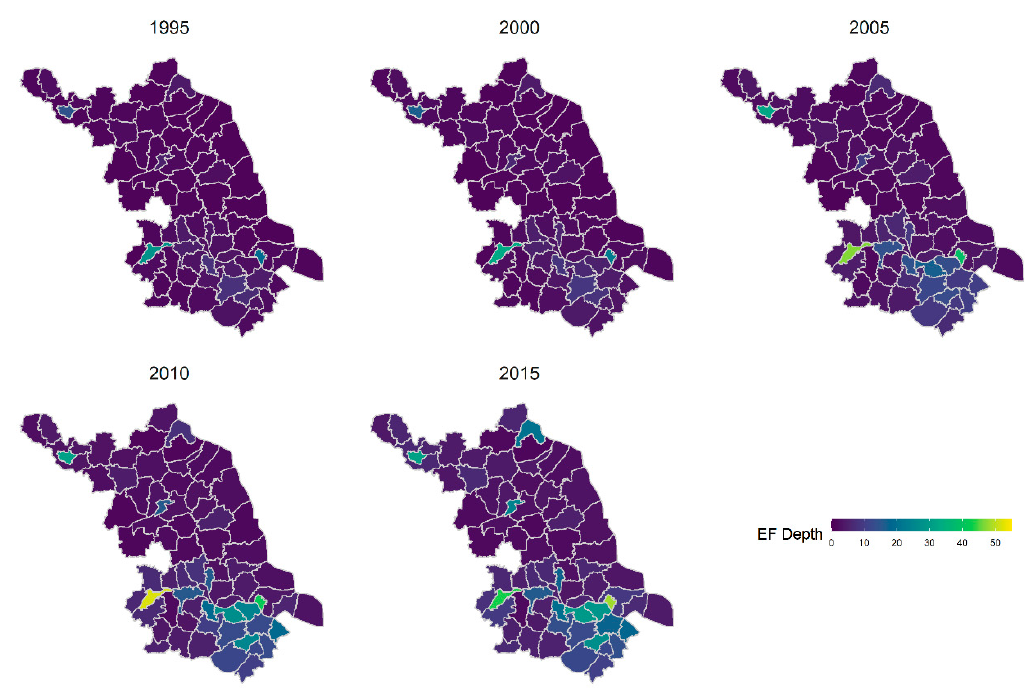
Figure 4. Jiangsu’s county-level ecological footprint depth from 1995–2015.